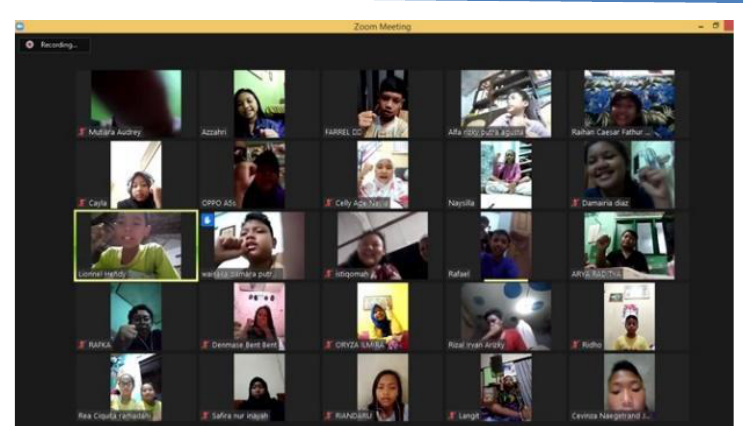
Figure 3 : Implementation of class 6 zoom meeting